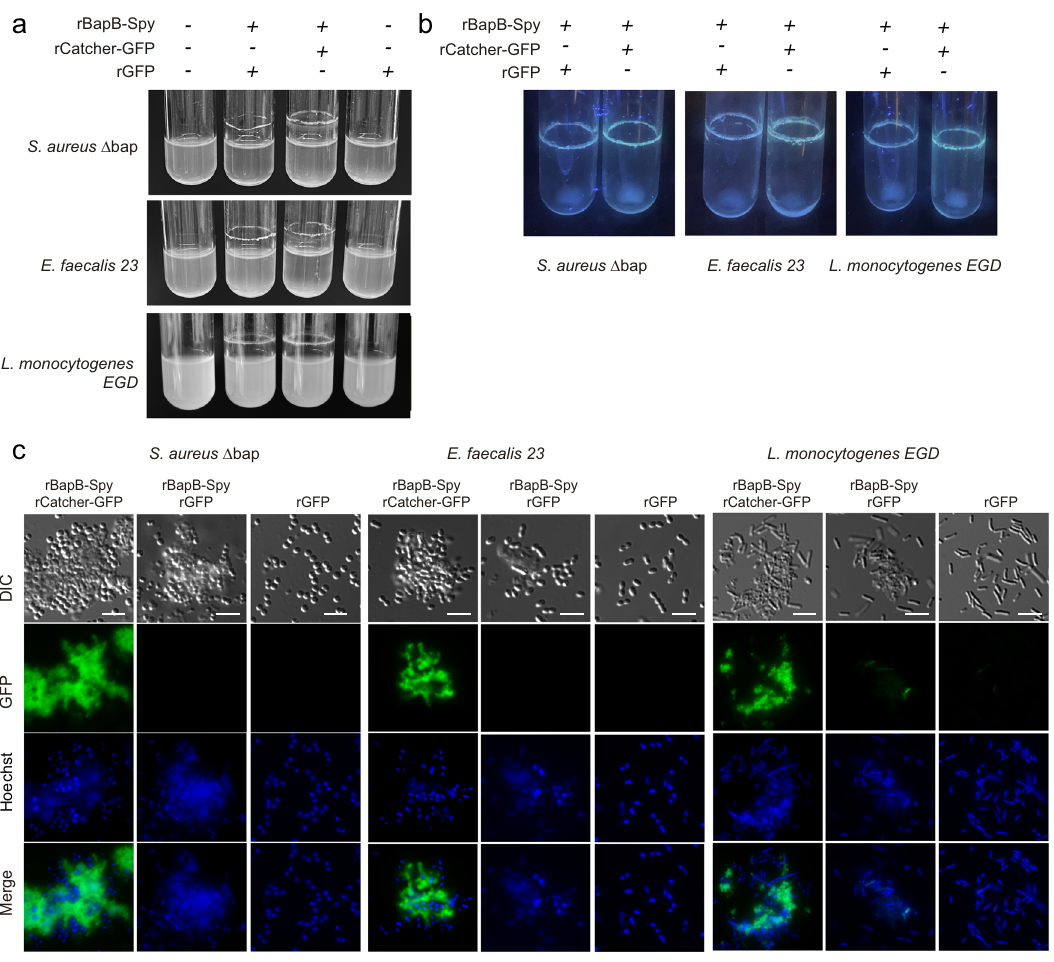
Fig. 8 Functionalization of bacteria through exogenous complementation with rBapB-Spy. a Exogenous complementation of bio fi lm negative bacteria S. aureus Δ bap, E. faecalis 23 and L. monocytogenes EGD strains with rBapB-Spy coupled to puri fi ed recombinant rCatcher-GFP and puri fi ed rGFP alone (used as a control). b Fluorescence under uv-light of the rings formed by S. aureus Δ bap, E. faecalis 23 and L. monocytogenes EGD cells when they are incubated with rBapB-Spy coupled to puri fi ed recombinant rCatcher-GFP and puri fi ed rGFP. c The fl uorescence of GFP and Hoechst, the combination of both signals (merge panels) and the differential interference contrast (DIC) images are shown. Scale bar of panels represents 5 μ